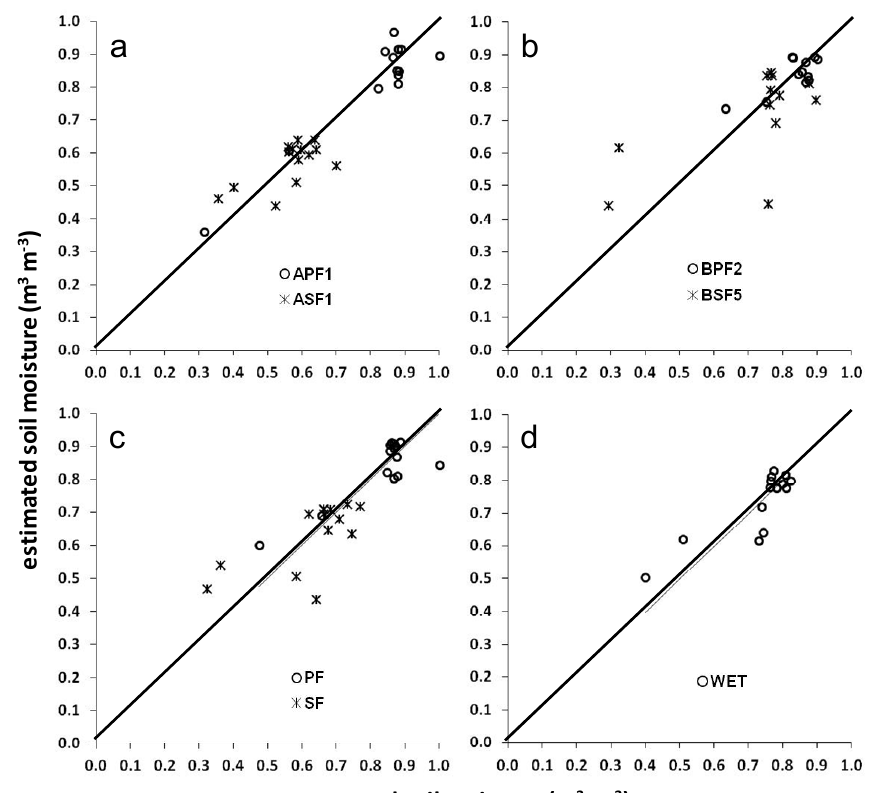
Figure 8. Error distribution from cross-validation: estimated and measured surface soil moisture. IA: FQ16 (36°) and FQ20 (39°): ( a ) peatland A, ( b ) peatland B, ( c ) permanently and seasonally flooded peatlands, ( d ) all